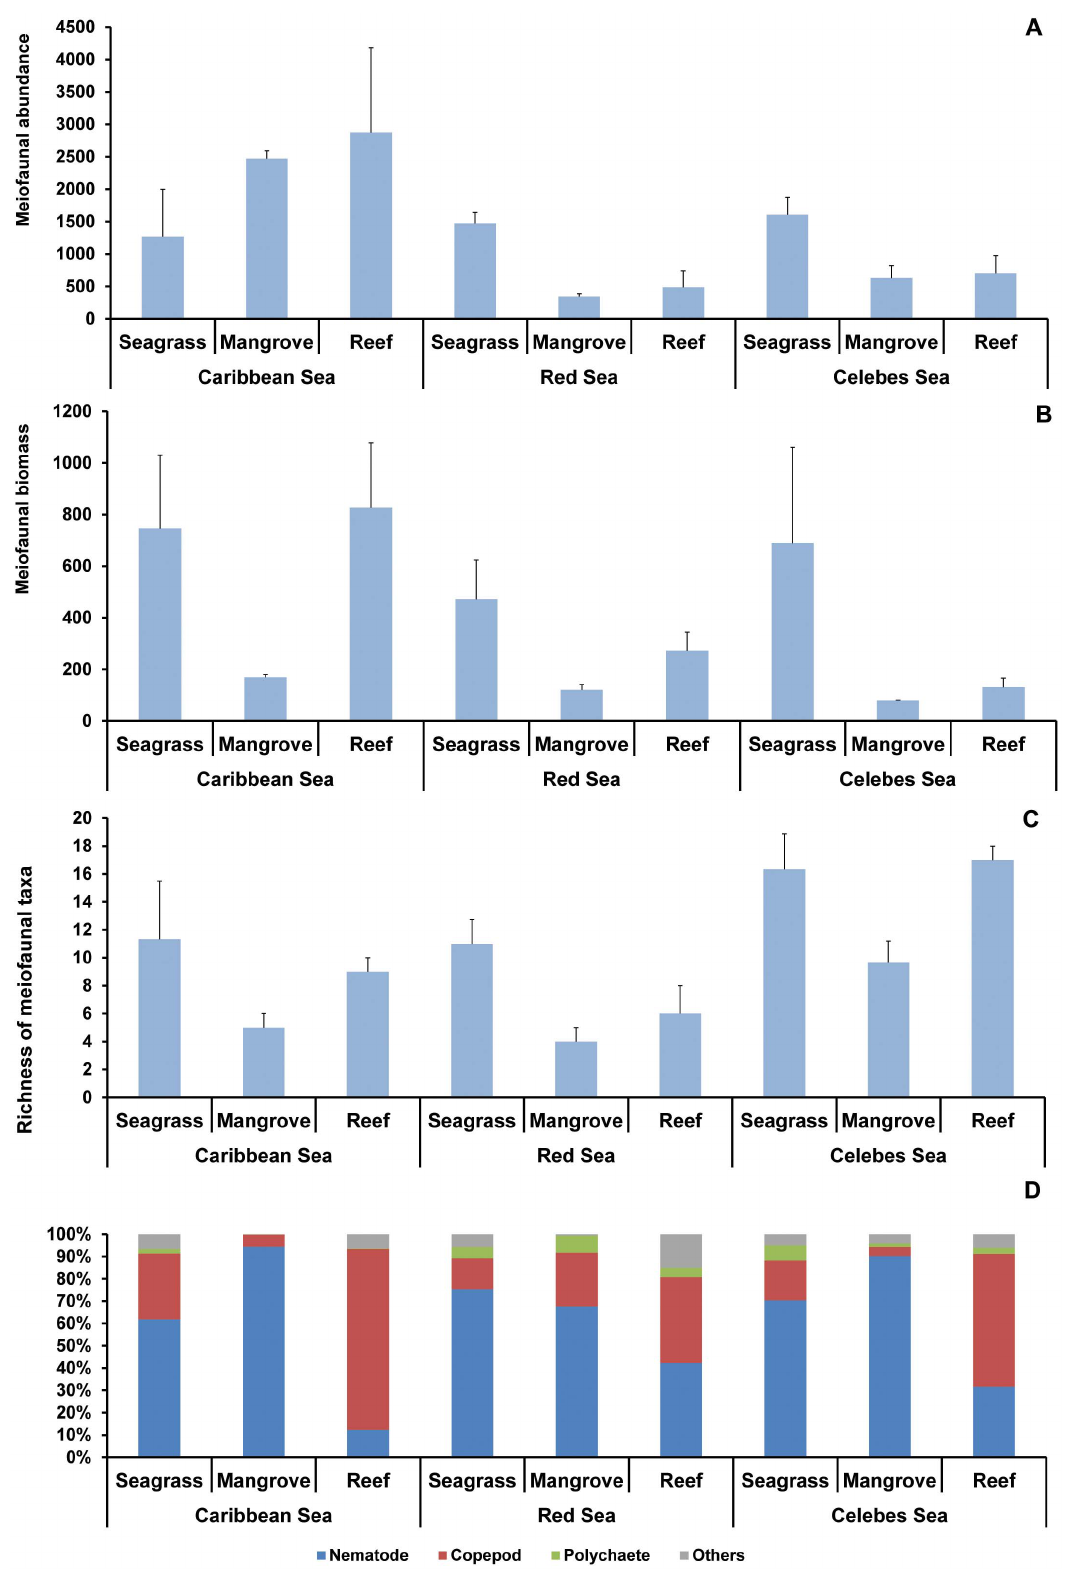
Figure 4. Meiofaunal assemblages. Illustrated are meiofaunal: A) abundance (ind 10 cm 2 2 ), B) biomass ( m gC 10 cm 2 2 ), C) richness of taxa, and D) assemblage composition in seagrass, mangrove and reef habitats of the Caribbean, Red and Celebes Seas. Reported are average values 6 standard deviation.